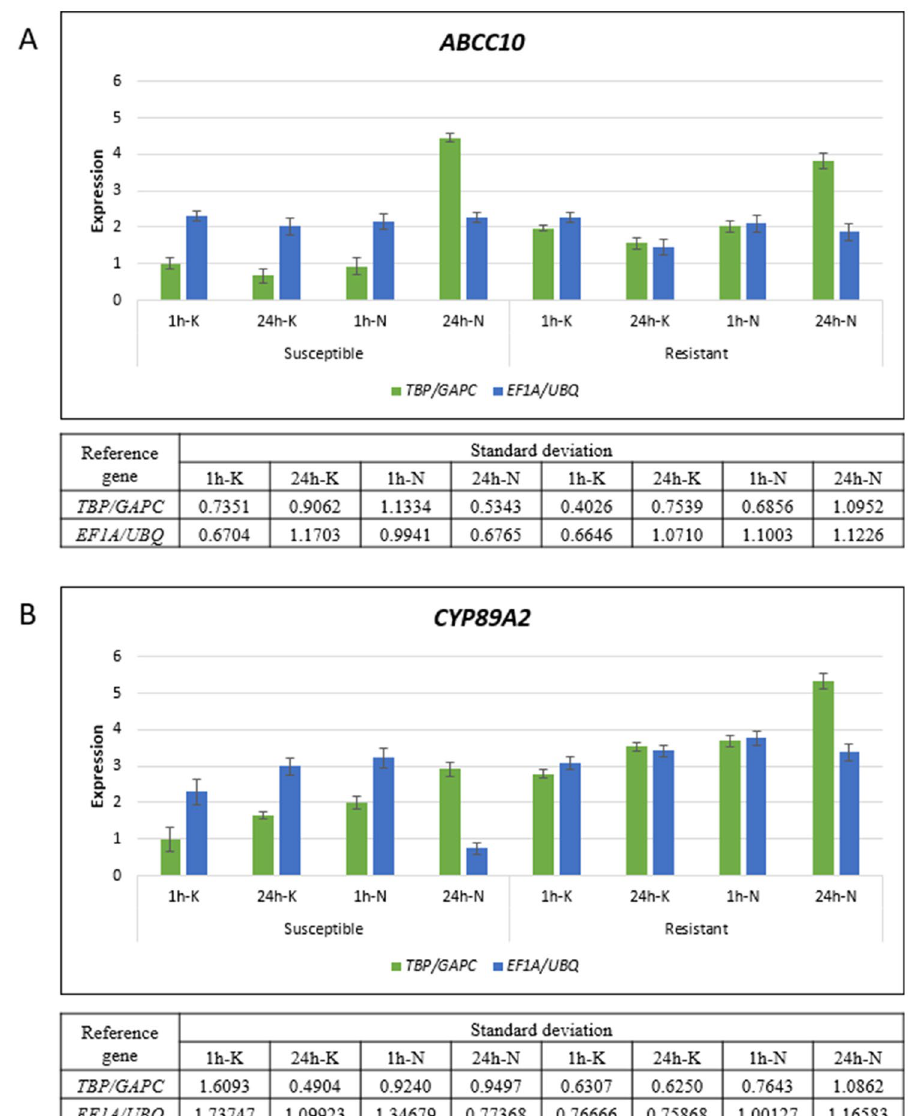
Figure 5. Expression of ABCC10 ( A ) and CYP89A2 ( B ) in Apera spica-venti plants non-treated or treated with pyroxsulam 1 h and 24 h after treatment with herbicide. RT-qPCR results were normalized against the most stably expressed HKGs, TBP and GAPC (green bars); and the least stably expressed, EF1A and UBQ (blue bars). Bars indicate mean expression, while the whiskers represent the standard error. ABCC10 and CYP89A2